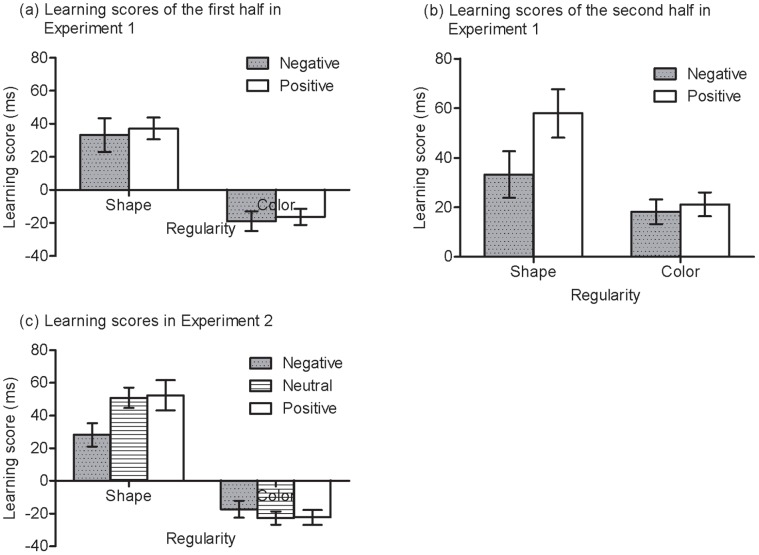
Learning effects for shape regularity and color regularity in Experiments 1 and 2.Error bars depict standard errors.